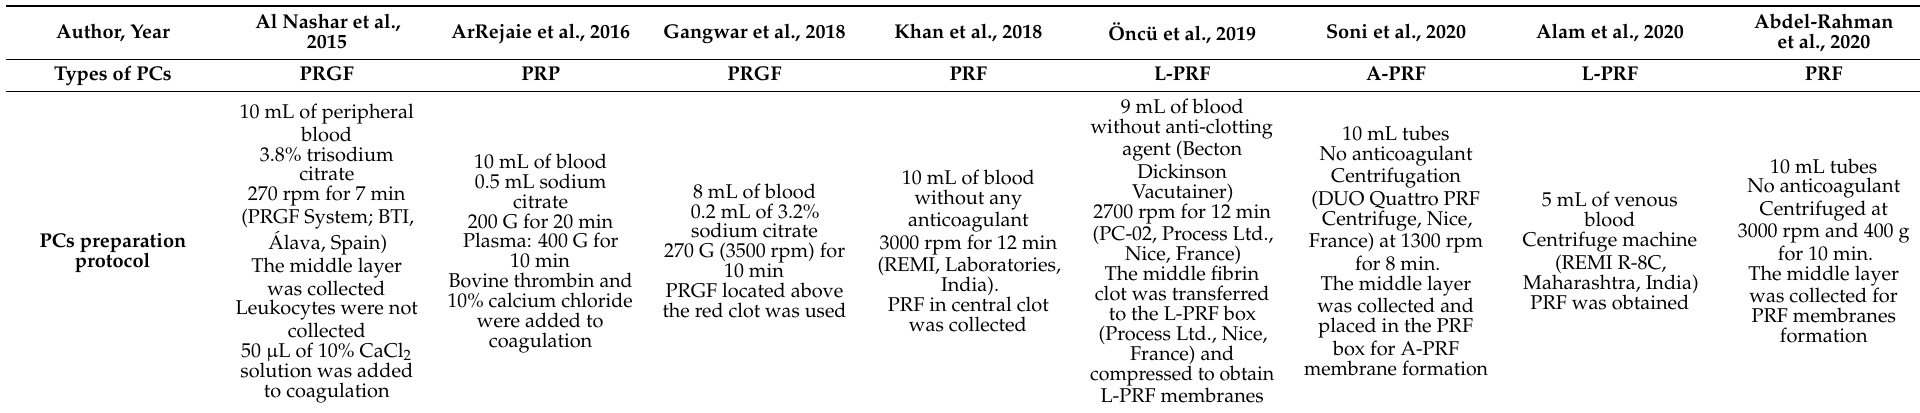
Table 3. Surgical and implants characteristics of the included